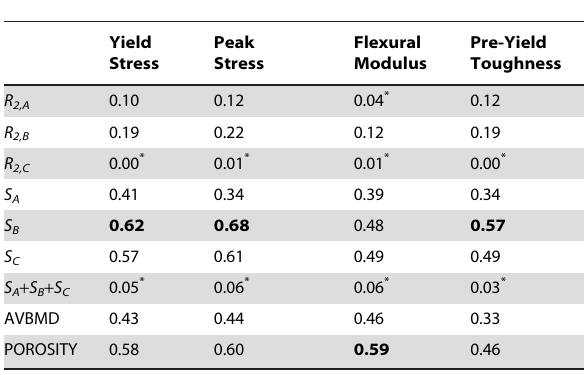
Table 1. A summary of Pearson’s r 2 for pairwise correlations between imaging measures ( 1 H NMR and X-ray) and mechanical properties.